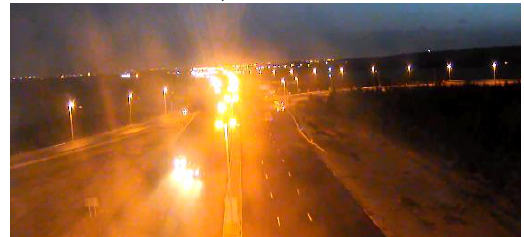
Figure 3: Information content reduction due to illumination problems .